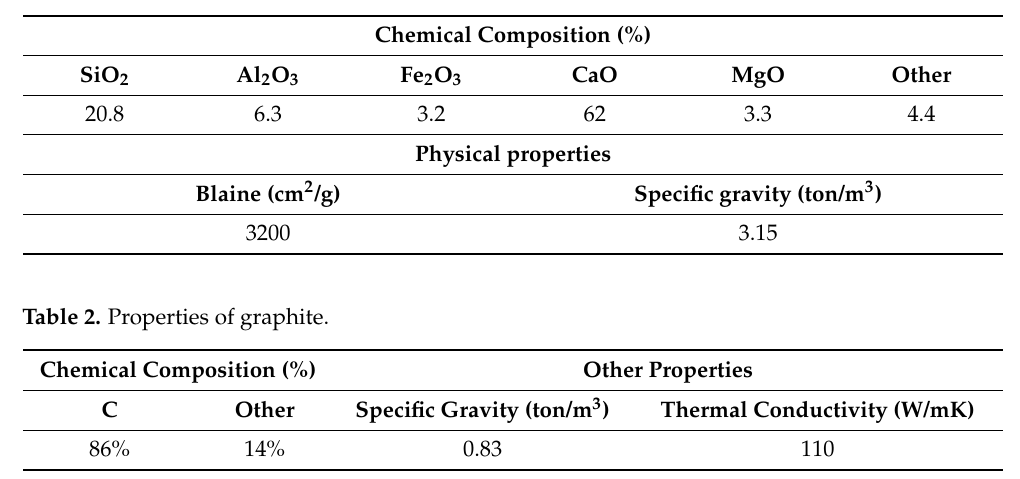
Table 1. Properties of OPC.